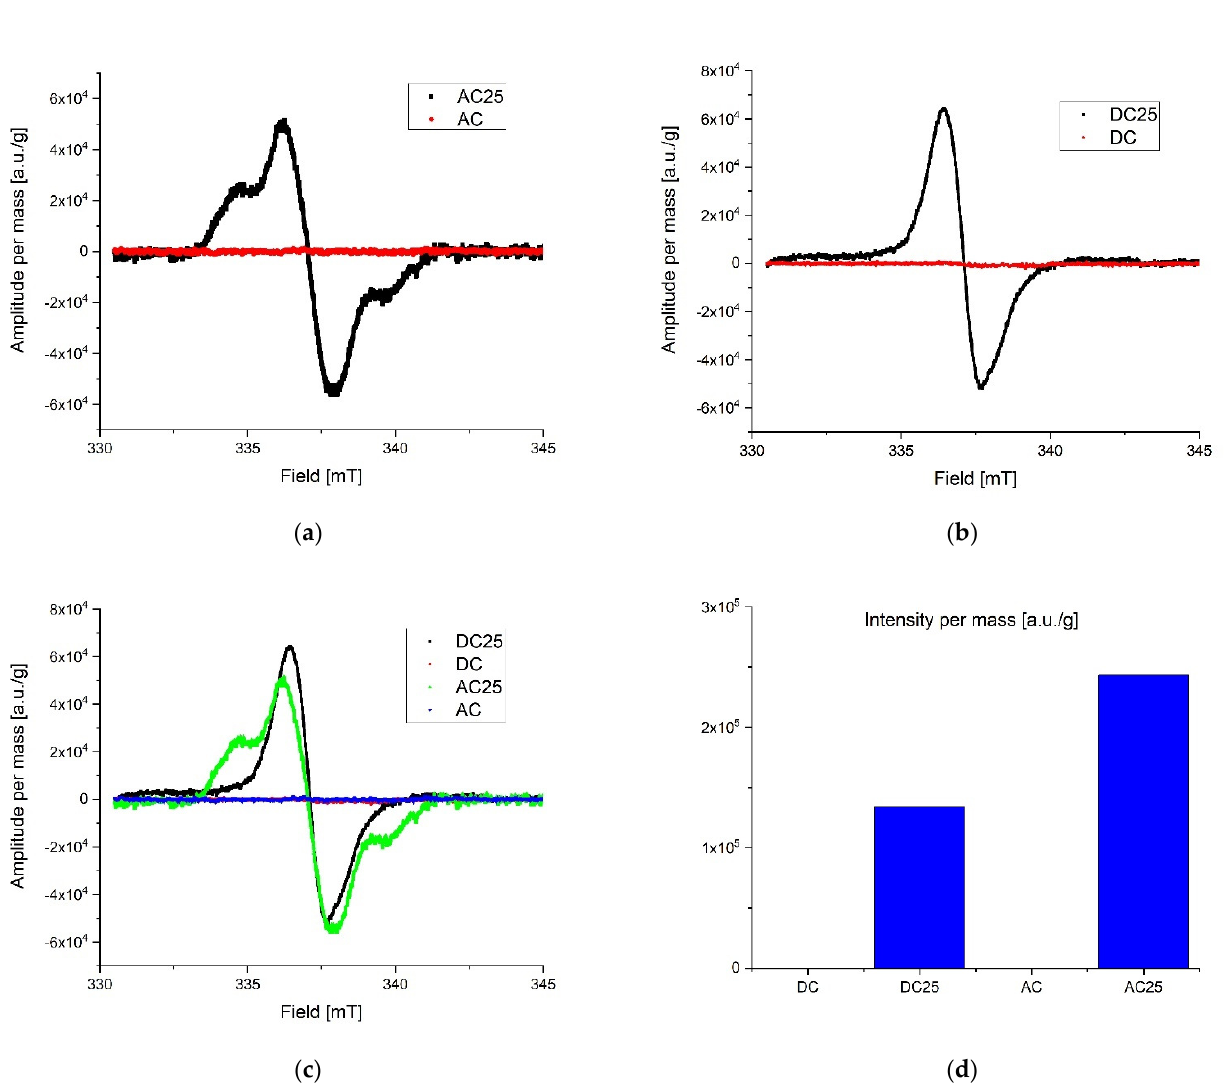
Figure 4. Low range EPR spectra: ( a ) overlap AC and AC 25; ( b ) overlap DC and DC 25; ( c ) overlap AC, AC 25, DC, DC 25; ( d ) intensity proportional to the number of spins in arbitrary units per 1 g mass. Table 3. Extended rangr EPR spectra